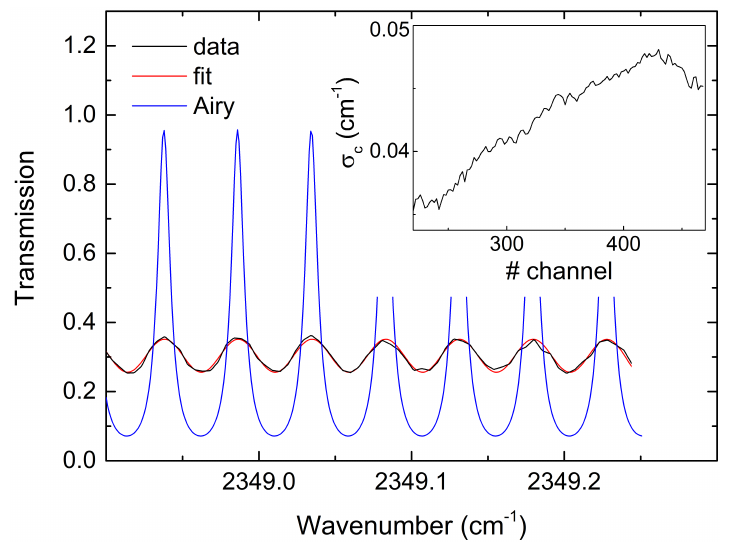
Figure 6. Section of the experimental transmission spectra of the Ge etalon derived from the mea- surements of Figure 4. blue—ideal Ge transmission function according to Airy-formula (formula (2)), red—best-fit of the experimental data to the model which includes spectral broadening of the laser light pulses (see text for details). Inset: Broadening parameter σ c as derived from the fitting model as a function of the pulse channel within the current